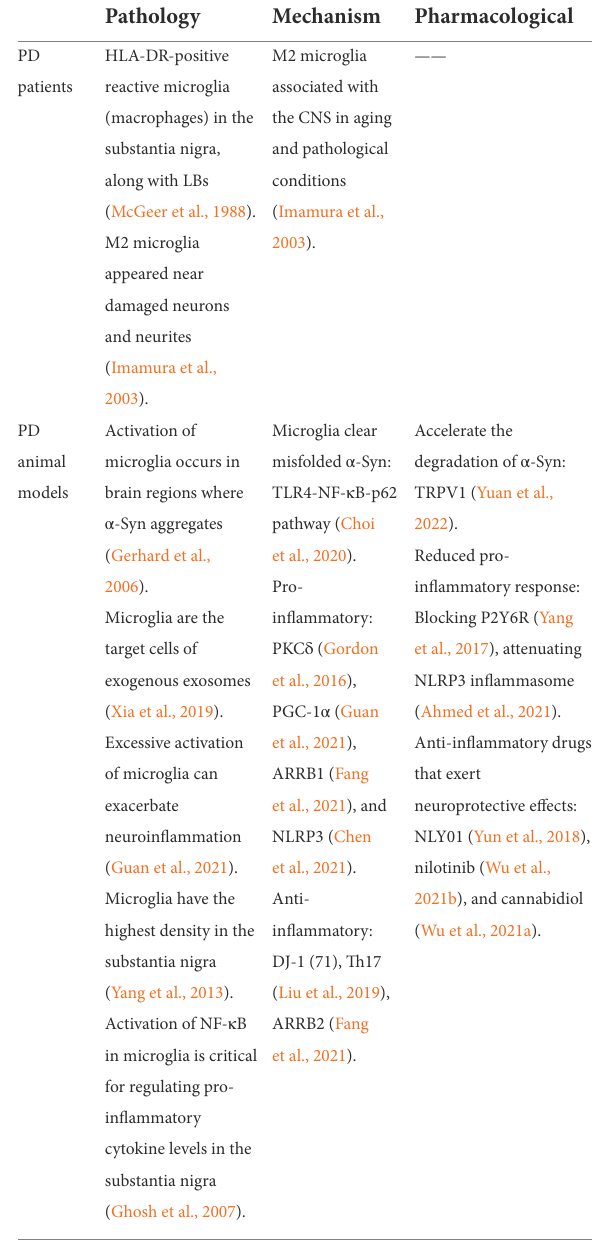
TABLE 1 Summary of microglial autophagy in